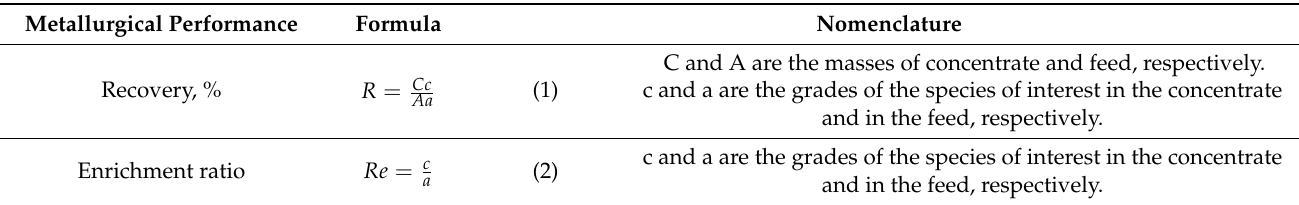
Table 2. Formulas used to calculate metallurgical indexes.